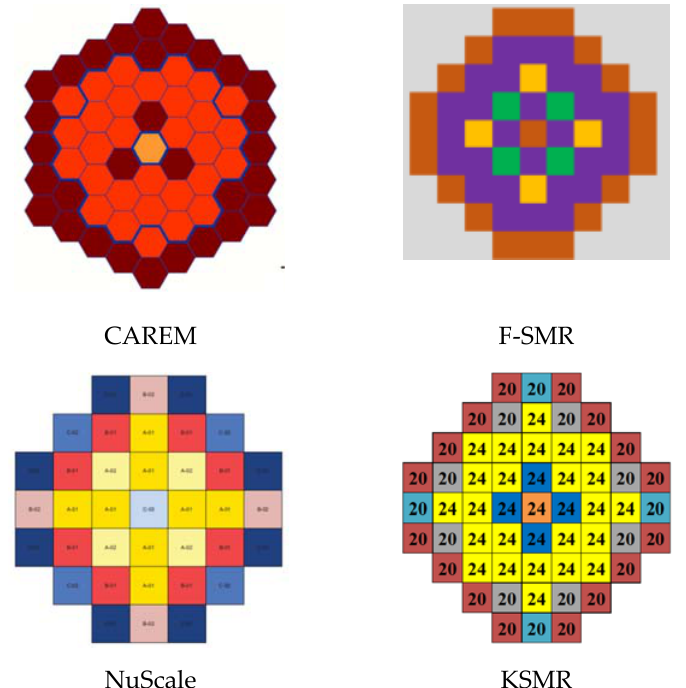
Figure 4. Schematic layout of the cores of four SMR ‐ designs.